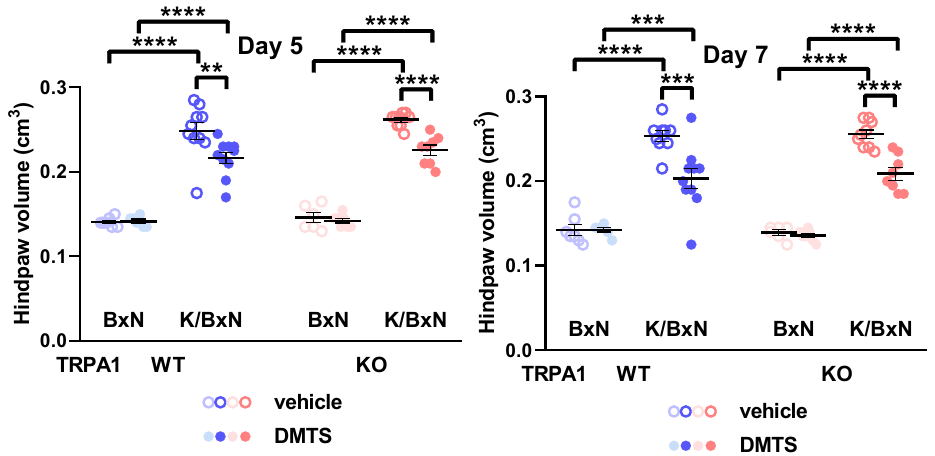
Figure 2. DMTS treatment ameliorated paw swelling in TRPA1 WT and KO mice 5 and 7 days after the initiation of serum-transfer arthritis. Volume of the hind paws was measured using plethysmometry. Symbols indicate individual data points. Open symbols represent vehicle-treated animals, while solid symbols illustrate DMTS-treated ones. Horizontal lines indicate the mean, and whiskers show the SEM. One-way ANOVA and Holm–Sidak’s test: n = 6–10. ** p < 0.01, *** p < 0.001, **** p < 0.0001 vs. indicated group.